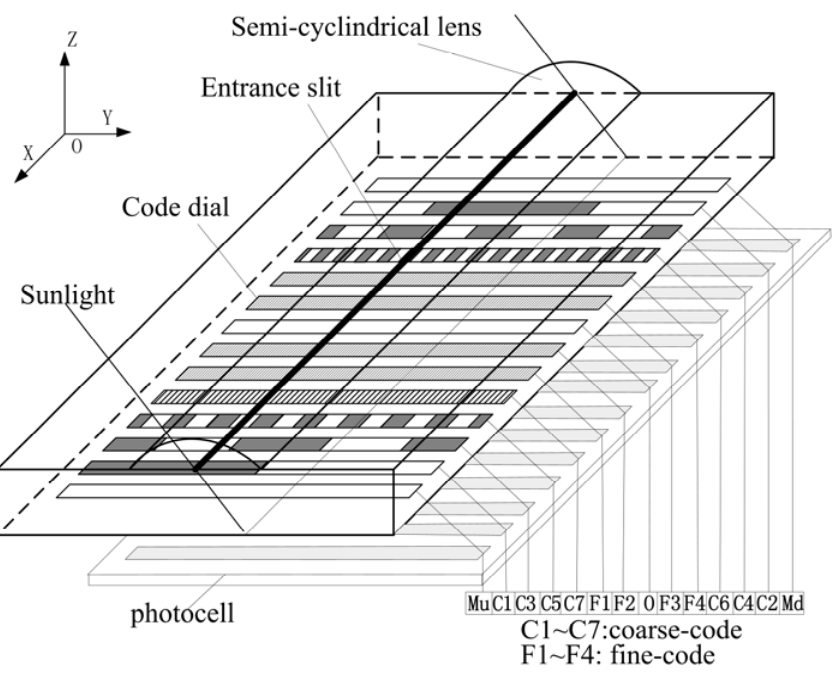
Figure 1. Optical sensing unit of an encoder sun